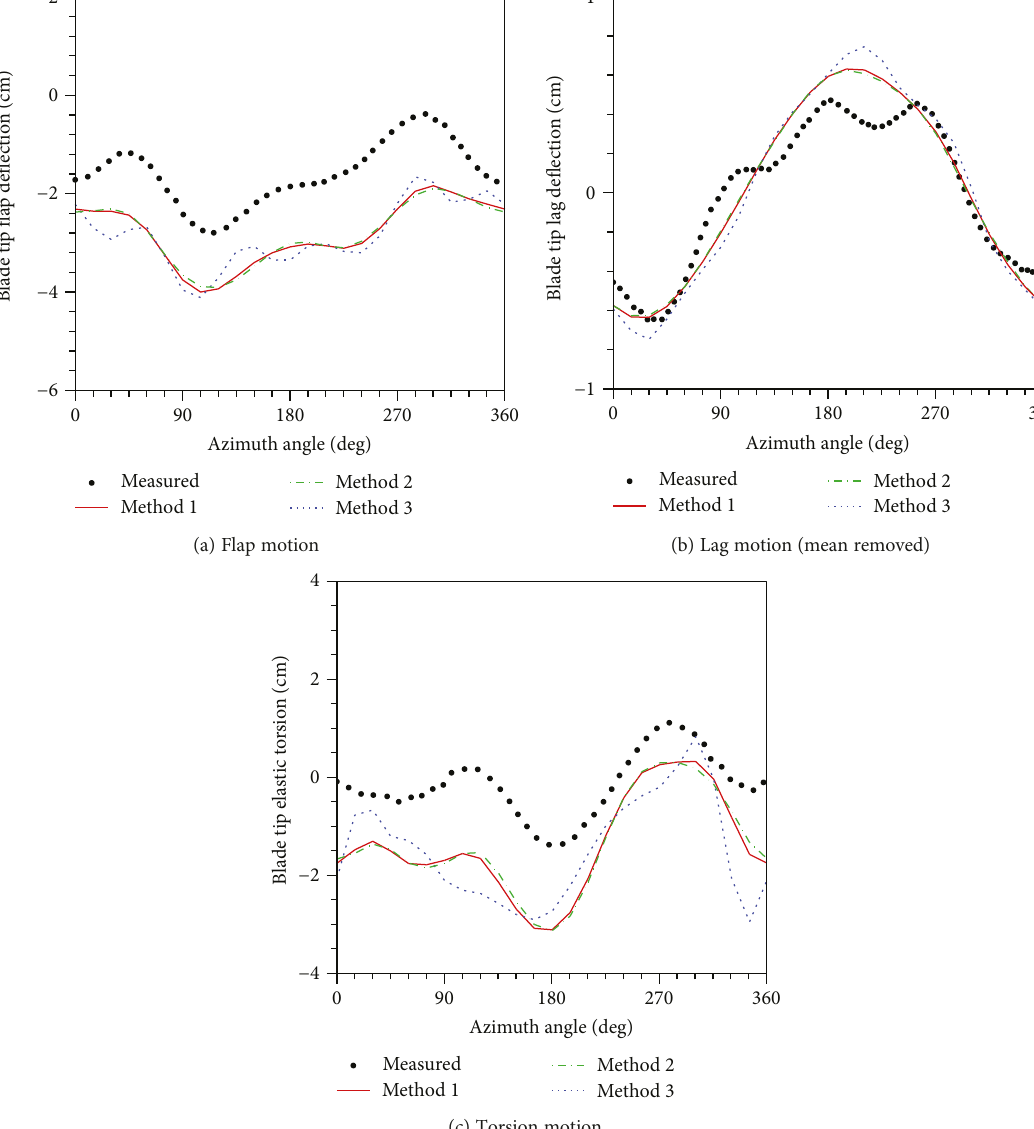
Figure 12: Comparison of blade tip elastic de fl